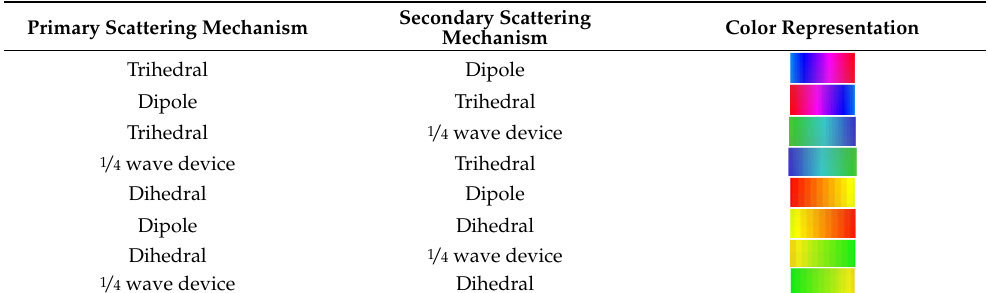
Table 4. Possible scattering pairs employed in the proposed method and their color representation.